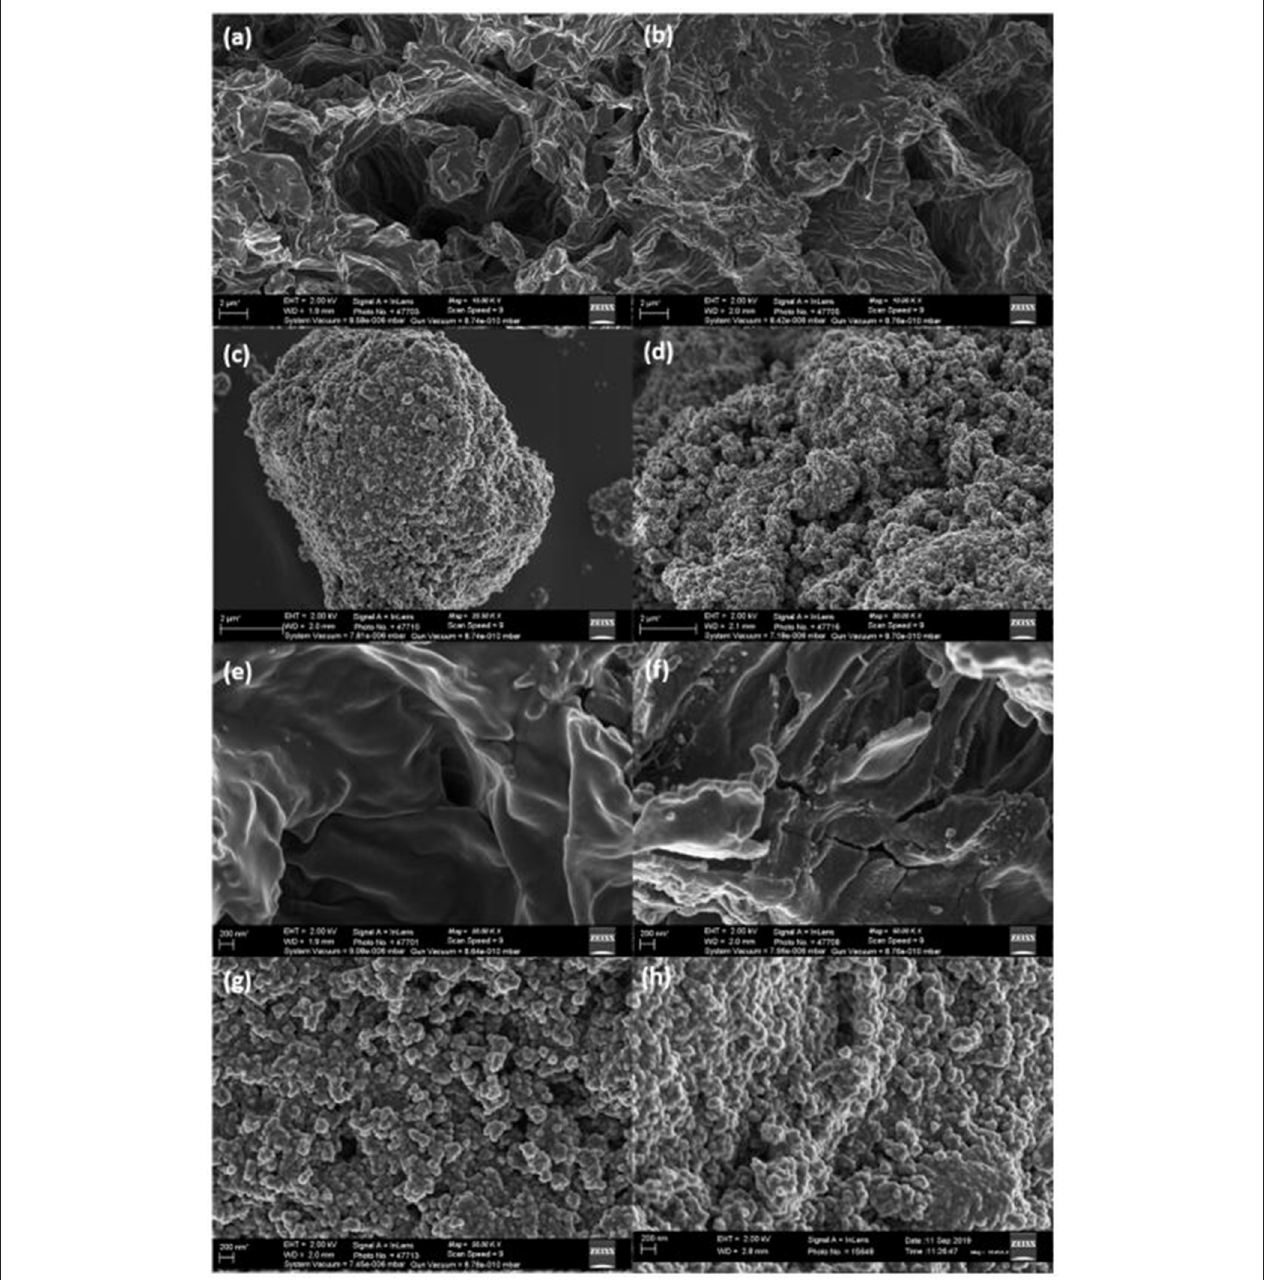
FIGURE 1 | FE-SEM images of (a) MO, (b) FMO, (c) Fe 3 O 4 and (d) Fe 3 O4/FMO at 2 µ m (e) MO (f) FMO (g) Fe 3 O 4 and (h) Fe 3 O 4 /FMO at 200nm.